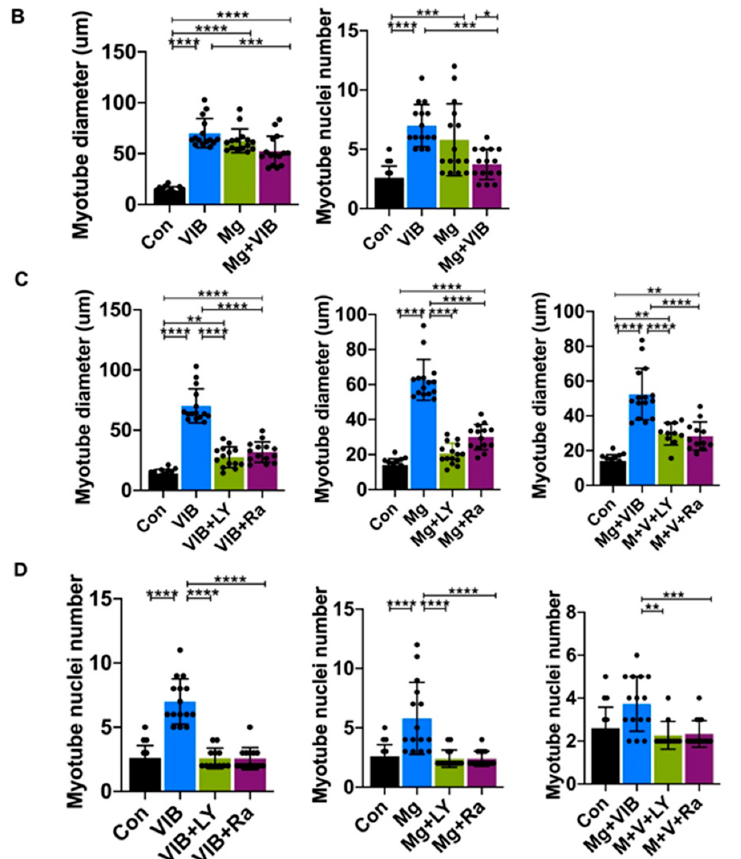
Figure 6. Myoblast differentiation and myotube formation in the C2C12 cell line with different treat- ments with PI3k/Akt inhibitor (LY294002) and mTOR inhibitor (Rapamycin). ( A ) Immunofluorescent staining of myotubes of VIB, Mg and combined treatment groups appeared morphologically distinct from the Con group. ( B ) Myotube diameters, myotube nuclei numbers of VIB, Mg and Mg + VIB groups showed a significant difference compared with the Con group. ( C,D ) Inhibitor groups showed significant smaller myotube diameters and myotube nuclei numbers. Scale Bar: 50 μ m. * p < 0.05, ** p < 0.01, *** p < 0.001 and **** p < 0.0001, n = 10–15.